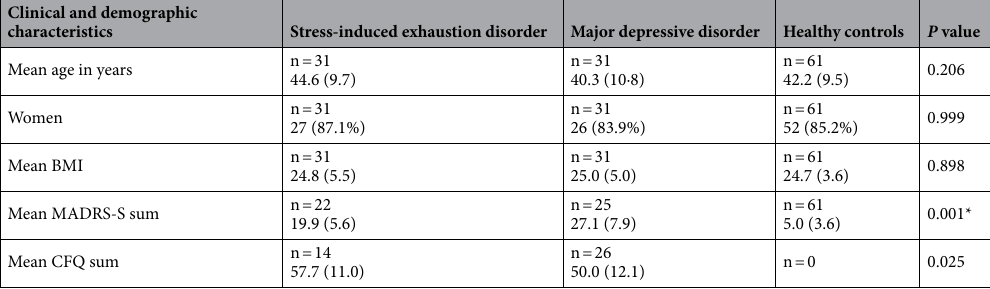
Table 2. Clinical and demographic characteristics of patients with stress-induced exhaustion disorder (n = 31), patients with major depressive disorder (n = 31), and healthy controls (n = 61). Data are mean (SD) or n (%). BMI body mass index, MADRS-S self-reported version of the Montgomery-Asberg Depression Rating Scale, CFQ Cognitive Failures Questionnaire. *Significant difference between patients with stress-induced exhaustion disorder and healthy controls and between patients with major depressive disorder and healthy